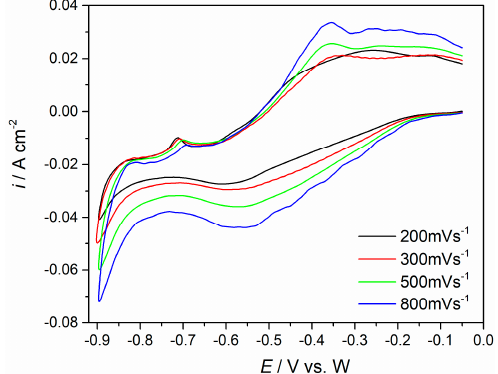
Figure 2. Cyclic voltammograms recorded with different sweep rates on Mo electrode in NdF 3 –LiF molten salt electrolyte, at 1323 K; the potential range used: E I = − 0.05 V to E F = − 0.90